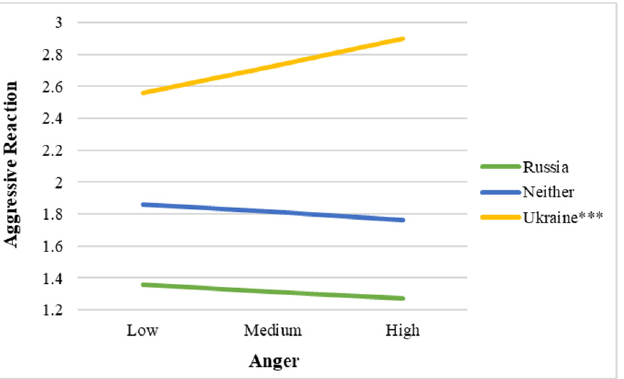
Figure A2. Plot of the relationship between Anger and Aggressive Reaction on Russia, Ukraine, and Neither Political Alignment; *** = p < 0.001.